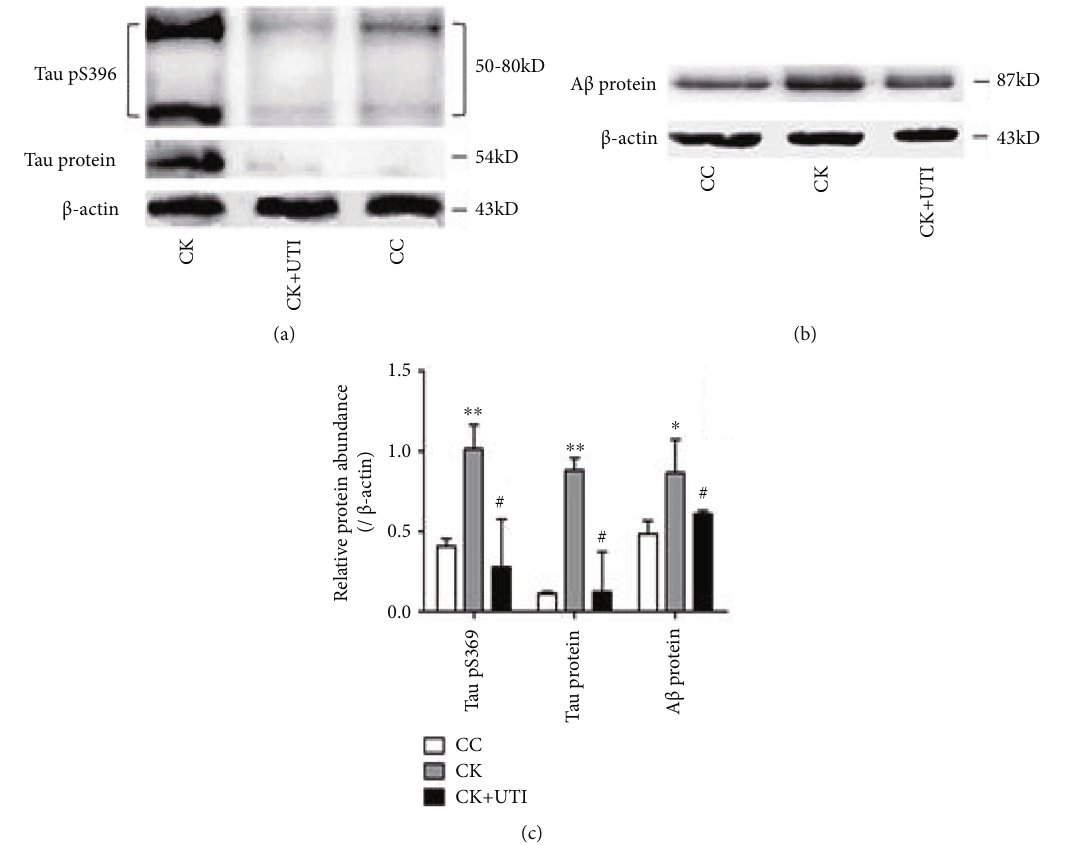
Figure 5: (a) and (b) showed the Western blotting results of Tau pS396, Tau protein, and A β protein. (c) illustrated the statistical value of each protein. ∗ P < 0 : 05 , ∗∗ P < 0 : 01 , and # P < 0 : 01